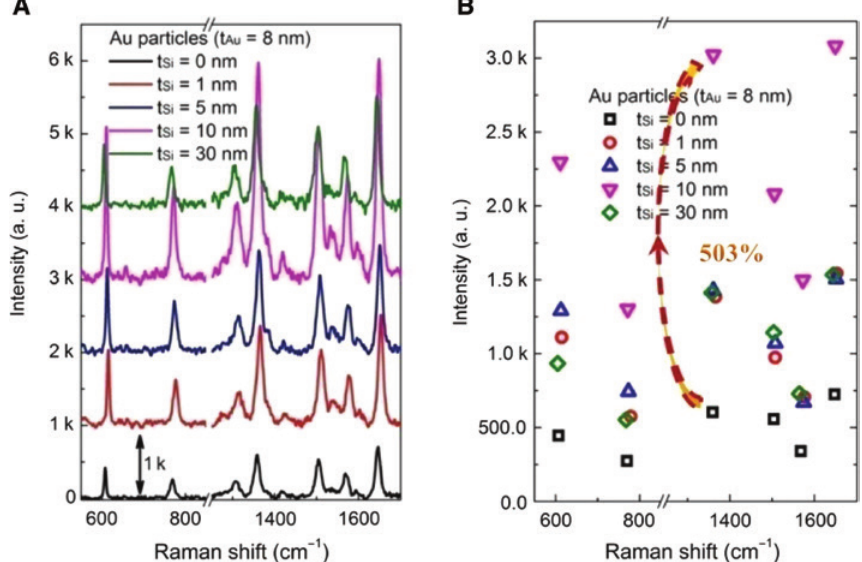
Figure 6: Surface-enhanced Raman scattering (SERS) performance for the Au particles based substrate. (A) SERS spectral properties of the Au particles under a tuning thickness of silicon buffer layers. (B) The plotted intensity spectrum of the Raman modes as a function of the silicon layer’s thickness. The dashed red arrow indicates a 503% enhancement factor for the 10-nm-thick silicon buffered Au particles to that of the Au particles structure without the silicon